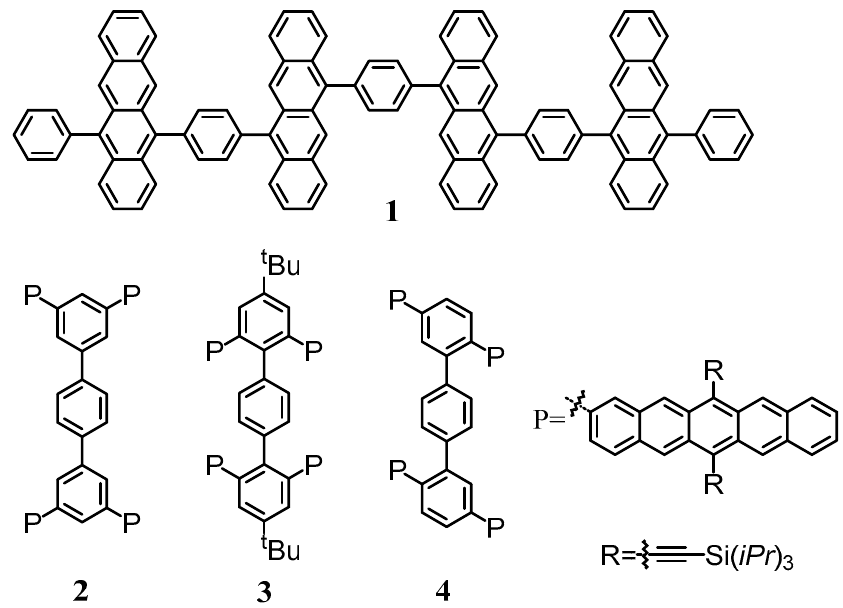
Figure 8. Structures of partial tetramers considered in the